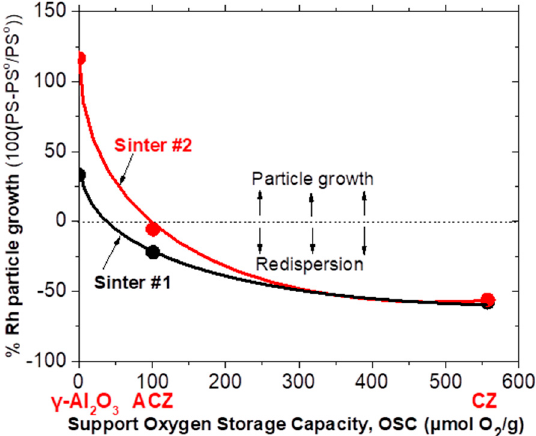
Figure 6. % Rh particle growth ( + ) or redispersion ( − ) versus oxygen storage capacity of the support for Sinter #1 and Sinter #2 conditions. (Results are based on H 2 -chemisorption data).